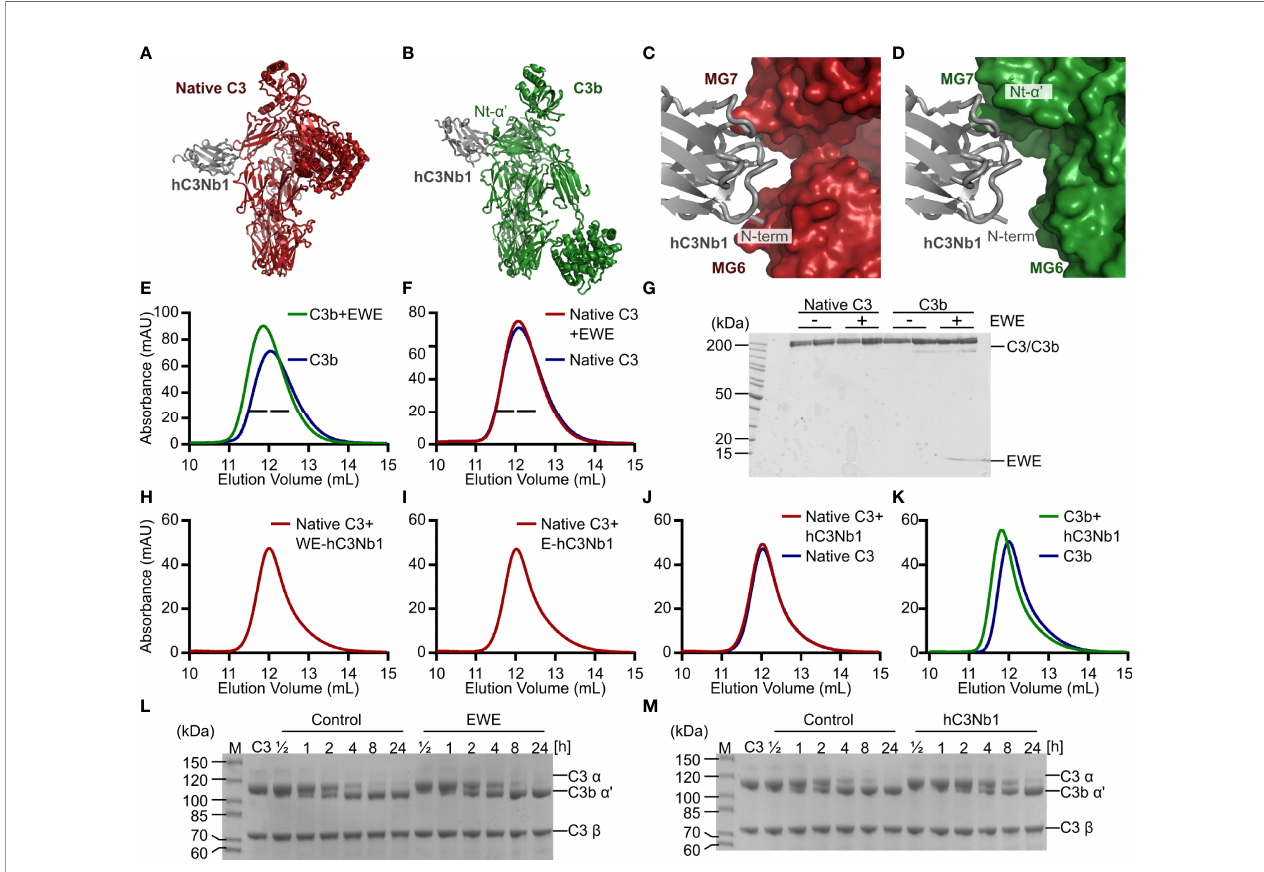
FIGURE 1 | Design and validation of EWE. (A, B) Structural comparison of the hC3Nb1 (grey) in complex with native C3 (red) and C3b (green). C3 and C3b are aligned on their MG-ring. (C, D) Comparison of the binding interface of hC3Nb1 in complex with C3 and C3b. The structures in panels (C, D) are aligned on the hC3Nb1 molecule. PDB entries are 6RU5 for the C3:hC3Nb1 complex and 6EHG for the C3b:hC3Nb1 complex. (E, F) SEC-based analyses of the interaction of EWE with C3b and native C3. (G) SDS-PAGE analysis of peak fractions from panels (E, F) , indicated by bars. (H – J) SEC-based analyses of the complex-formation between native C3 and WE-hC3Nb1, E-hC3Nb1, and hC3Nb1. (K) SEC-based analysis of the interaction between hC3Nb1 and C3b. (L, M) Cleavage of C3 by CVFBb was monitored in presence or absence of EWE or hC3Nb1. mAU , milli absorbance units. M , molecular weight